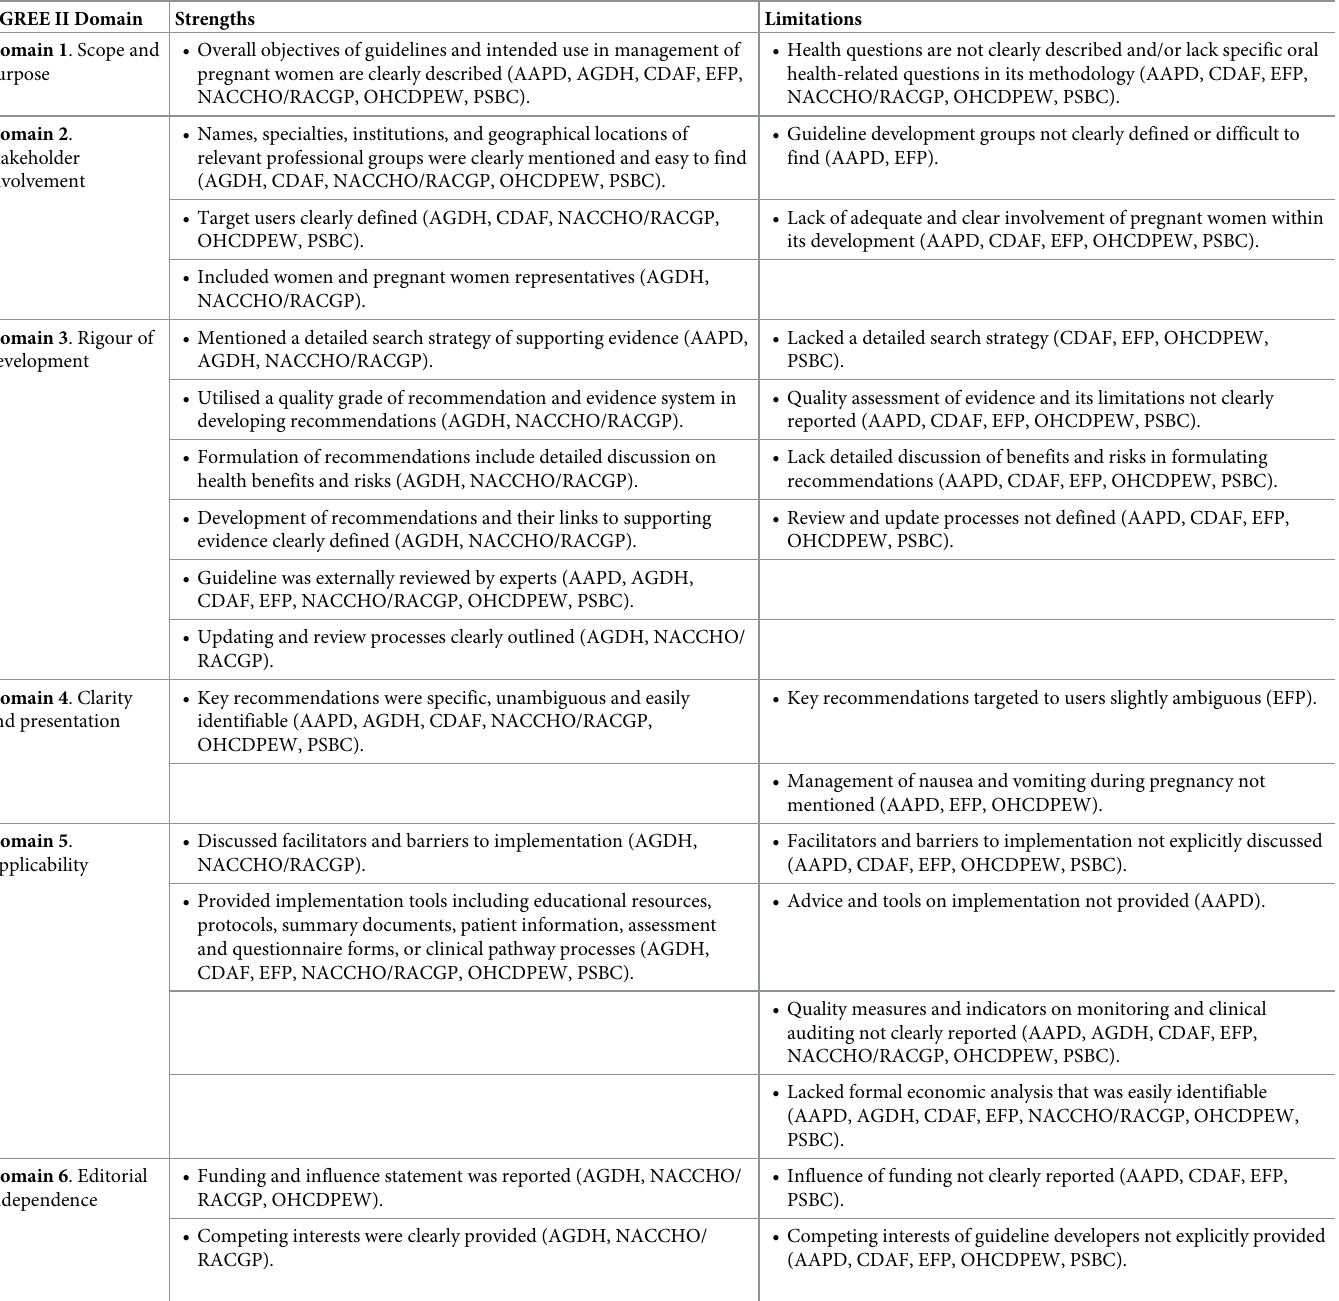
Table 5. Strengths and limitations of included guidance documents according to AGREE II